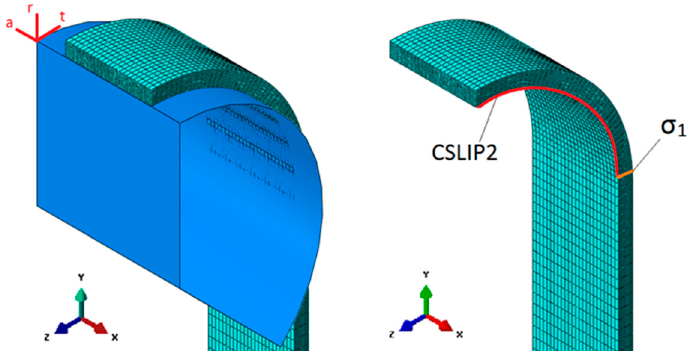
Polymers 2016 , 8 , 124 8 of 12 Figure 8. Temperature curves of fretting fatigue tested CFRP straps. Curves shown for straps tested at an upper load level between 750 and 1100 MPa. 5.1. Finite Element Analysis With the strap’s three symmetry planes, the model used for the FEA could be simplified with a 1/8 model of the strap. The pin was modelled as an analytical rigid surface in order to reduce computational costs without losing the results’ accuracy compared to a solid, deformable CFRP pin. The 1 mm thick and 6 mm wide strap was meshed with 42,028 linear hexahedral elements of type C3D8, resulting in a total of 47,775 nodes. The mesh was locally refined with an approximate element size of 0.1 mm × 0.25 mm × 0.5 mm in the vertex area and 0.1 mm × 0.25 mm × 3 mm in the centre of the shaft. This was found to be a good tradeoff between result accuracy and computational cost. Table 3 lists the elastic material properties that where defined by the engineering constants. For better results, the strap was loaded by defining a pin displacement rather than applying a load to it. The pin-strap interaction was defined over a surface-to-surface interaction, with the pin acting as master and the strap as slave. The coefficient of friction ( cof ) in the contact area varied between cof = 0–0.5, which is in the range of values reported in the literature ( cof = 0.2–0.68, depending on contact material and fibre orientation) [26–28]. Figure 9 illustrates the 1/8 model of the strap and shows where the numerical values of the stresses and displacements were read. Table 3. Engineering constants used for the FEA.